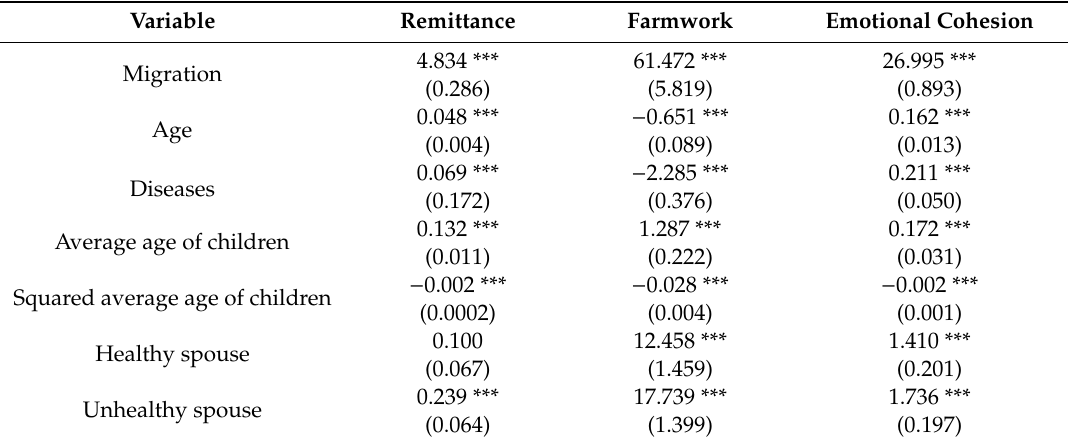
Table 4. The e ff ect of child migration on inter-generational